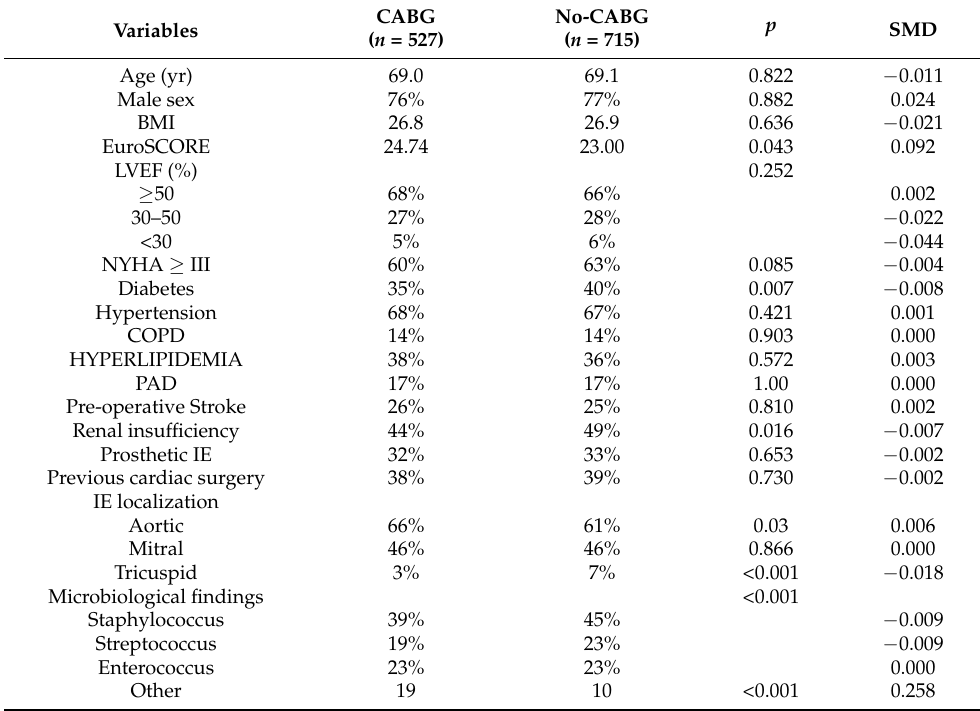
Table 3. Baseline characteristics of patients with CAD after inverse probability weighting.